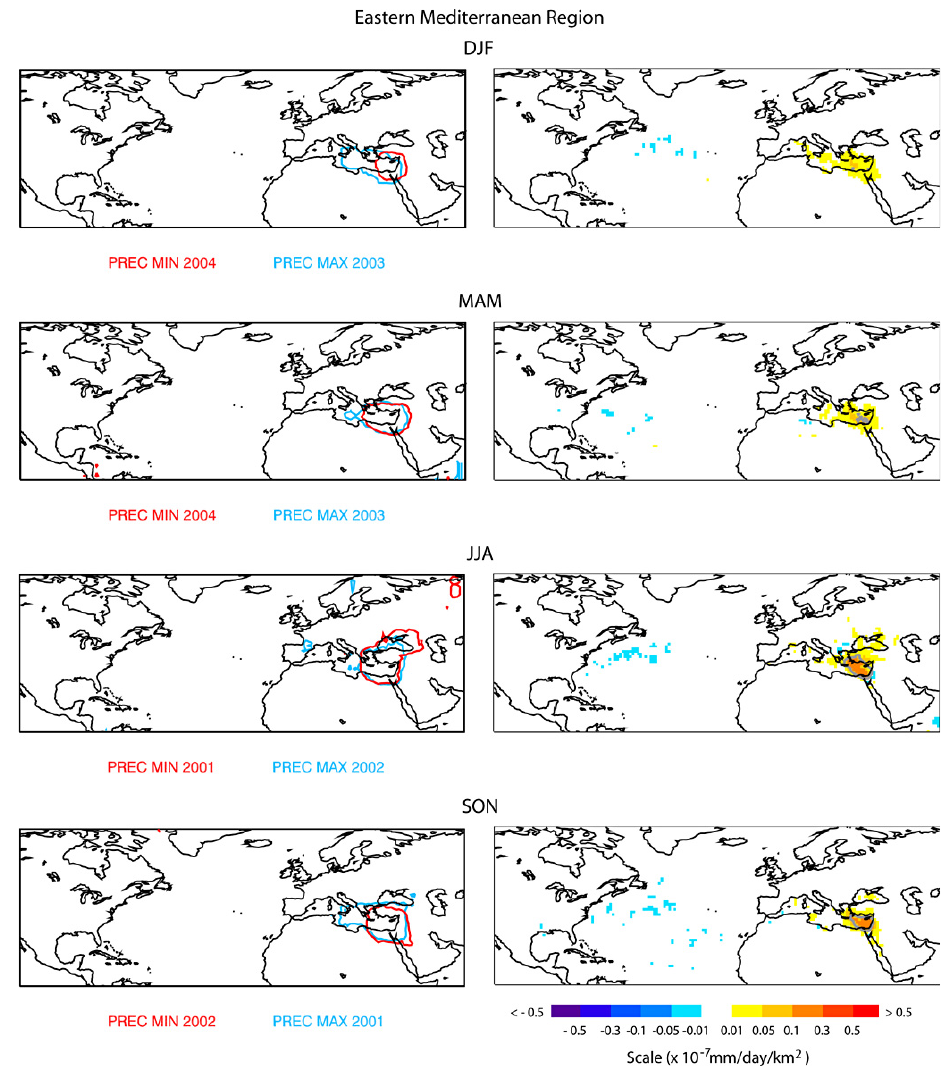
Fig. 6. As Fig. 2, but for the Eastern Mediterranean subregion (EM), considering its equivalent area as 504492km 2 .